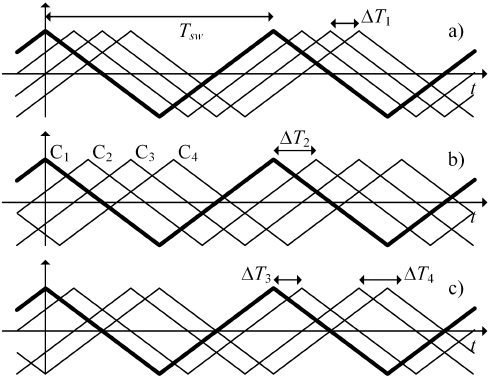
Figure 9. Single-phase full-bridge interleaving with four bridges: a) symmetric; b) regular asymmetric and c) irregular